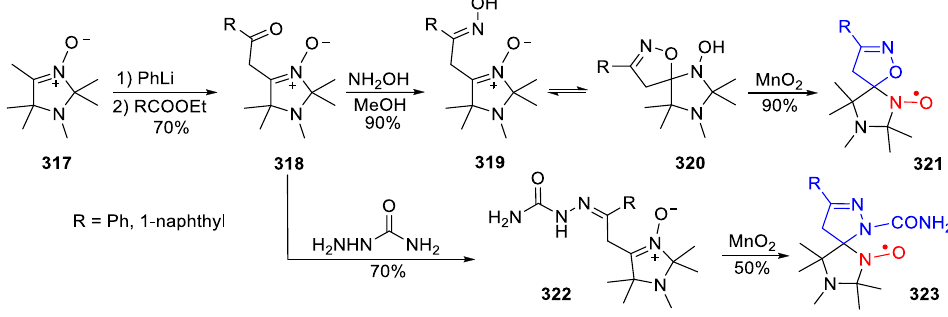
Figure 12. An EPR spectrum of SNR 323 .